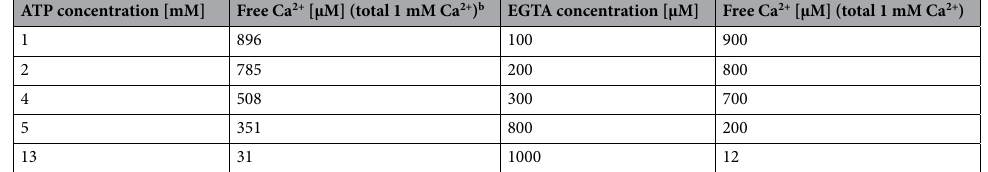
We tested an assay that uses fluorescence anisotropy measurement to monitor the cis - and trans -membrane interaction of synaptotagmin-1 (Fig. 2). Direct measurement of the cis - and trans -membrane interaction of endogenous synaptotagmin-1 in native vesicle membranes is impossible, so we monitored the binding of an exogenously-added C2AB domain of synaptotagmin-1 (Syt 97-421 ), which was labelled with Alexa Fluor 488 at S342C (Fig. 2a). We took advantage of a single fluorescent labelling for anisotropy measurement to monitor the interaction of the C2AB domain with native vesicles or liposomes; the membrane-bound C2AB domain leads to increase of fluorescence anisotropy due to a reduction in the rotational mobility 10 (Fig. 2a,b). It is noted that our experiments using the cytoplasmic C2AB domain are intended to shed light on the cis - and trans -interactions, but the geometry is not truly being imitated. We first monitored the cis -membrane interaction between the C2AB domain and the LDCV membranes (Fig. 2a). The presence of 1 mM Ca 2+ increased fluorescence anisotropy; this change indicates that the C2AB domains bind to LDCV membranes in a Ca 2+ -dependent manner. Five sequential applications of 1 mM ATP gradually decreased the anisotropy signal by chelating Ca 2+ ; this result suggests dissociation of the C2AB domain from LDCVs (Fig. 2a). 5 mM ATP in the presence of 1 mM Ca 2+ almost completely disrupted the cis -membrane interaction of the C2AB domain with the LDCV membranes (Fig. 2a); free [Ca 2+ ] in the presence of Mg 2+ , ATP and EGTA was calibrated using the MaxChelator simulation program and free [Ca 2+ ] was 351 µM in case of 5 mM ATP and 1 mM Ca 2+ (Table 1).